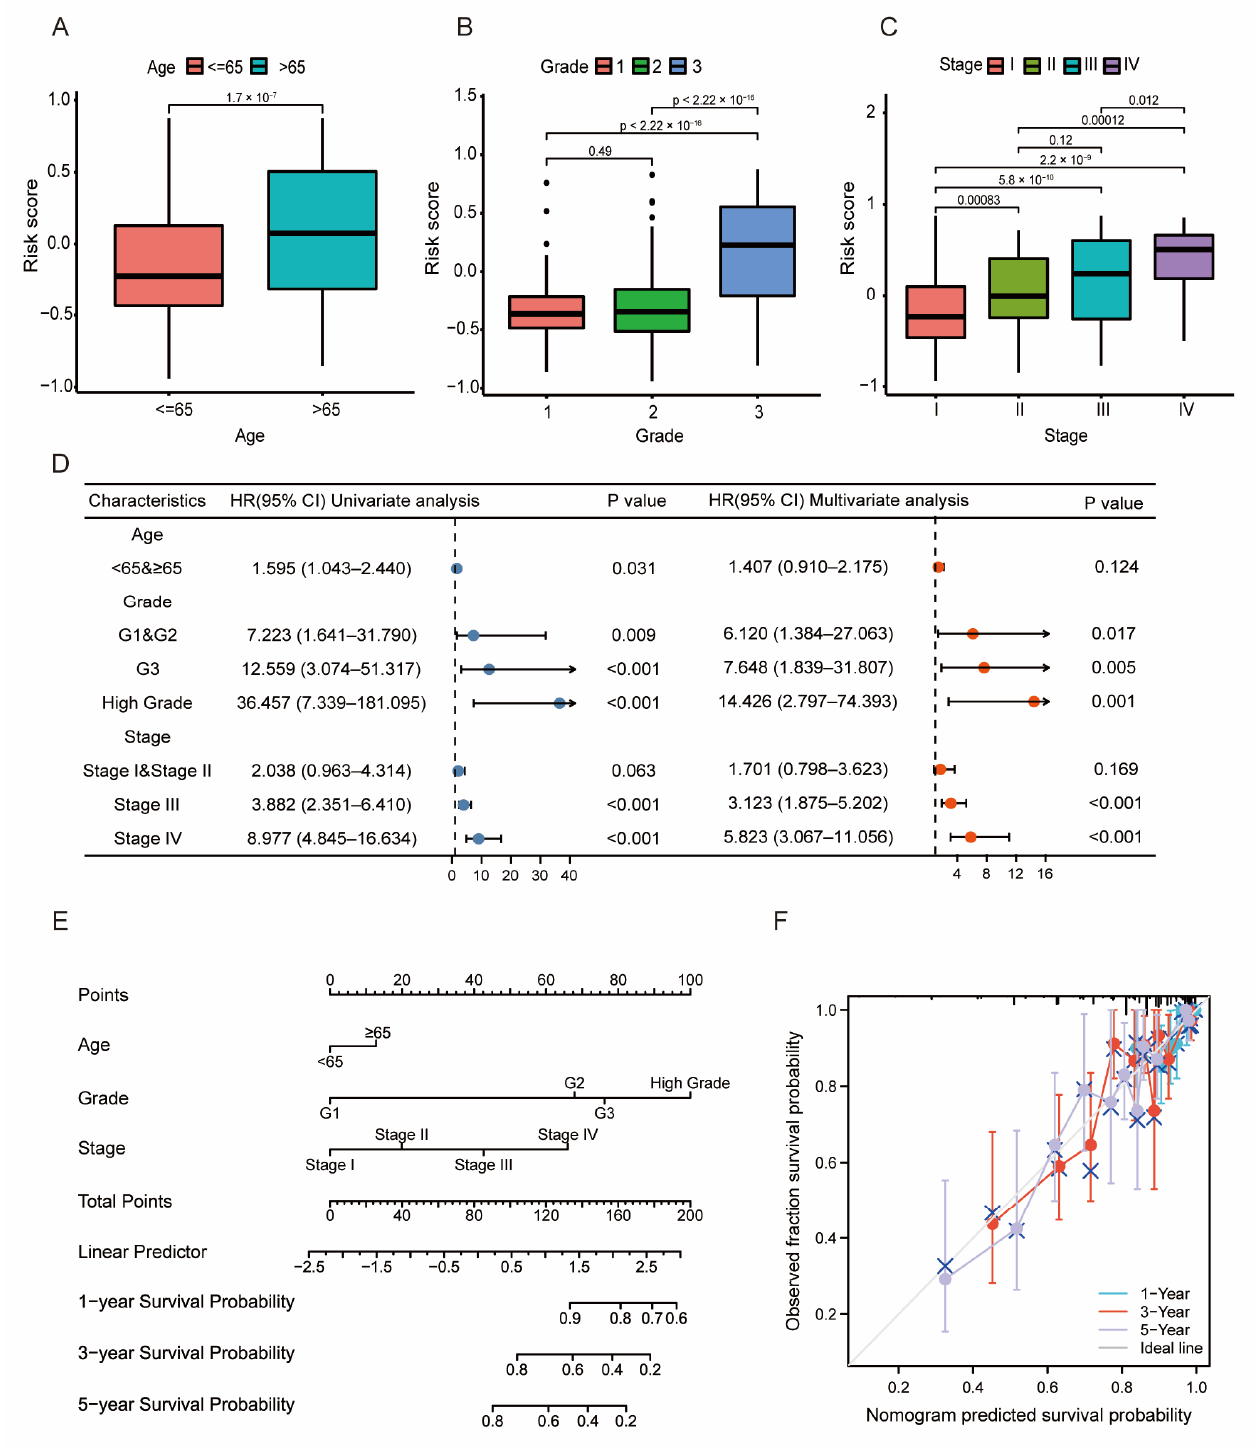
Figure 3. Establishment of a predictive nomogram. ( A – C ). The pathological characteristics age, grade, and stage in the high- and low-risk groups. Patients in the high-risk group had an older age and higher grade and stage. ( D ) Univariate and multivariate Cox regression analyses of the signature and clinical characteristics. ( E ) Nomogram to predict 1-year, 3-year, and 5-year overall survival times. ( F ) Calibration curve to assess the accuracy of the nomogram. The C-index was 0.767 (0.741– 0.793).